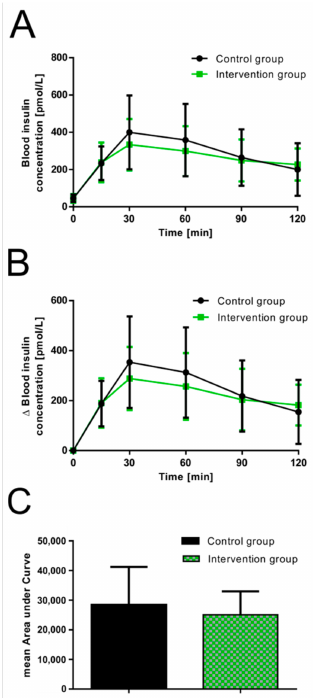
Figure 2. E ff ect of 2.5 mL guava fruit extract on postprandial insulin secretion [pmol / L] in healthy male and female volunteers. ( A ) Absolute changes in mean postprandial insulin responses over 120 min compared to control. ( B ) Relative changes in mean postprandial insulin concentrations over the basal fasting plasma insulin levels over 120 min compared to control. ( C ) Calculated mean areas under the curve based on relative changes in insulin responses. Values are presented as the means ± SD; control group: n = 15 and intervention group: n =